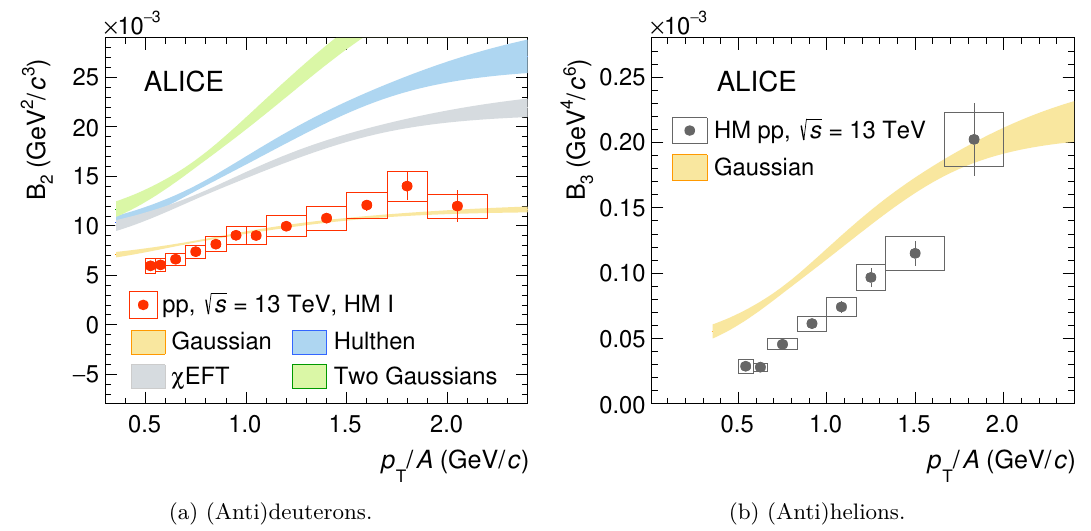
Figure 3. Comparison between measurements and theoretical predictions for the coalescence pa- rameters B 2 for (anti)deuterons (a) and B 3 for (anti)helions (b) as a function of p T /A . Vertical bars and boxes represent statistical and systematic uncertainties, respectively. Theoretical predictions are obtained using different wave functions to describe nuclei: Gaussian (yellow), Hulthen (blue), χ EFT (gray) and two Gaussians